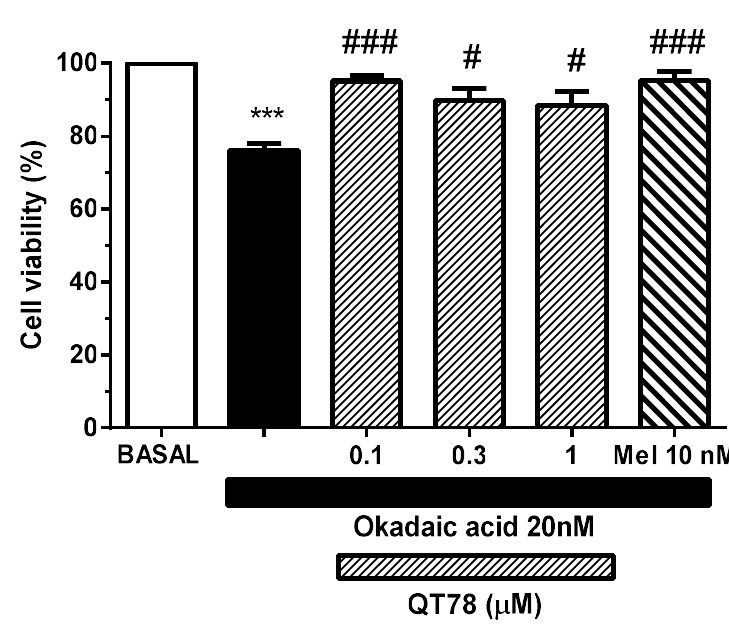
Figure 5. Neuroprotective properties of QT78 (0.1, 0.3 and 1 µ M) in SH-SY5Y cells against ( A ) rotenone (30 µ M) / oligomycin A (10 µ M) or ( B ) okadaic acid (20 nM) toxicity. Data are expressed as means ± SEM of five different cultures performed in triplicate (untreated control set to 100%). *** p < 0.001, compared to control; ### p < 0.001, ## p < 0.01 and # p < 0.05 compared to toxic stimuli.